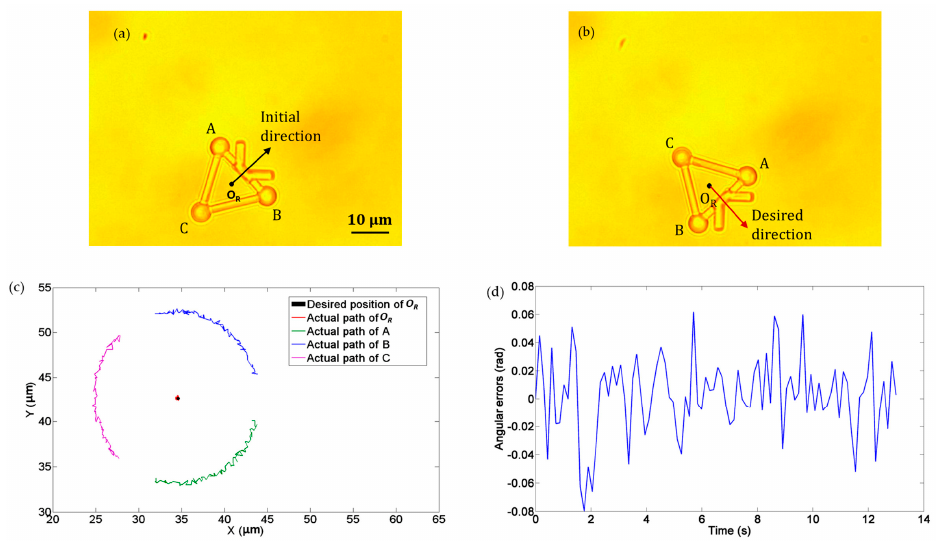
Figure 10. Experiments of rotation movement of the microtool. ( a ) Initial direction. ( b ) Desired direction. ( c ) Desired and actual movement paths. The black dot denotes the desired position of O R and the red dot indicates the actual path of O R . ( d ) Absolute directional errors.